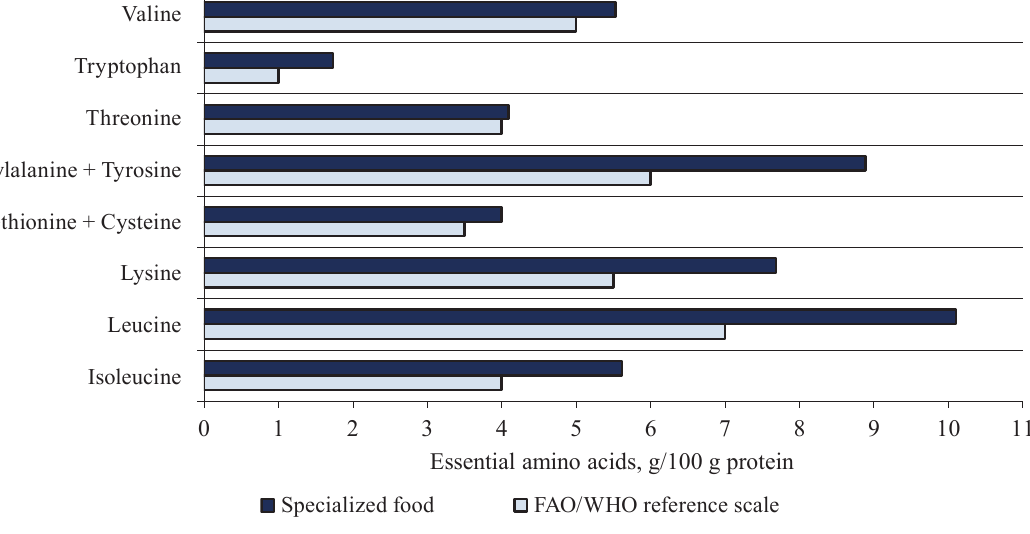
Figure 1 Essential amino acids in the specialized food protein component (compared to a reference